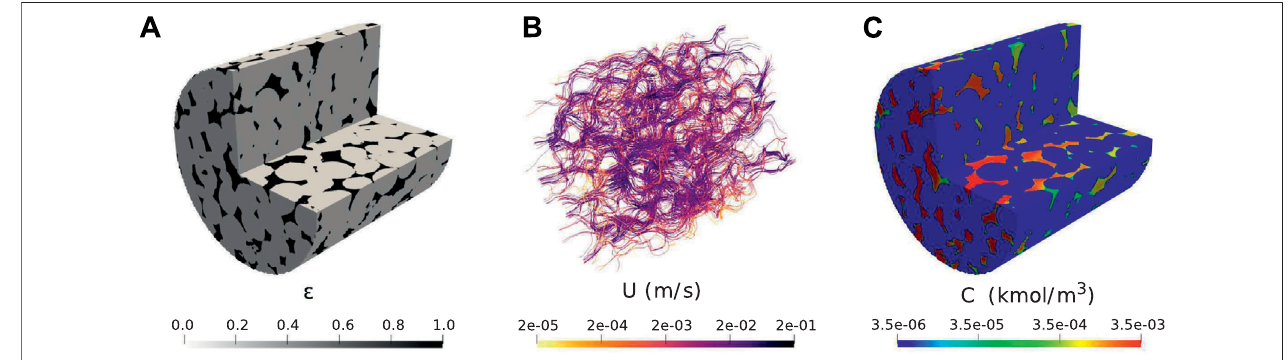
FIGURE8| Initialconditionforsimulationofdissolutionina3Dmicro-CTimageofcarbonate: (A) initiallocalporosity fi eld; (B) Initialcalculatedvelocity fi eld; (C) Initial calculated concentration fi eld ( Pe =190, Da =4.4×10 – 2 ).